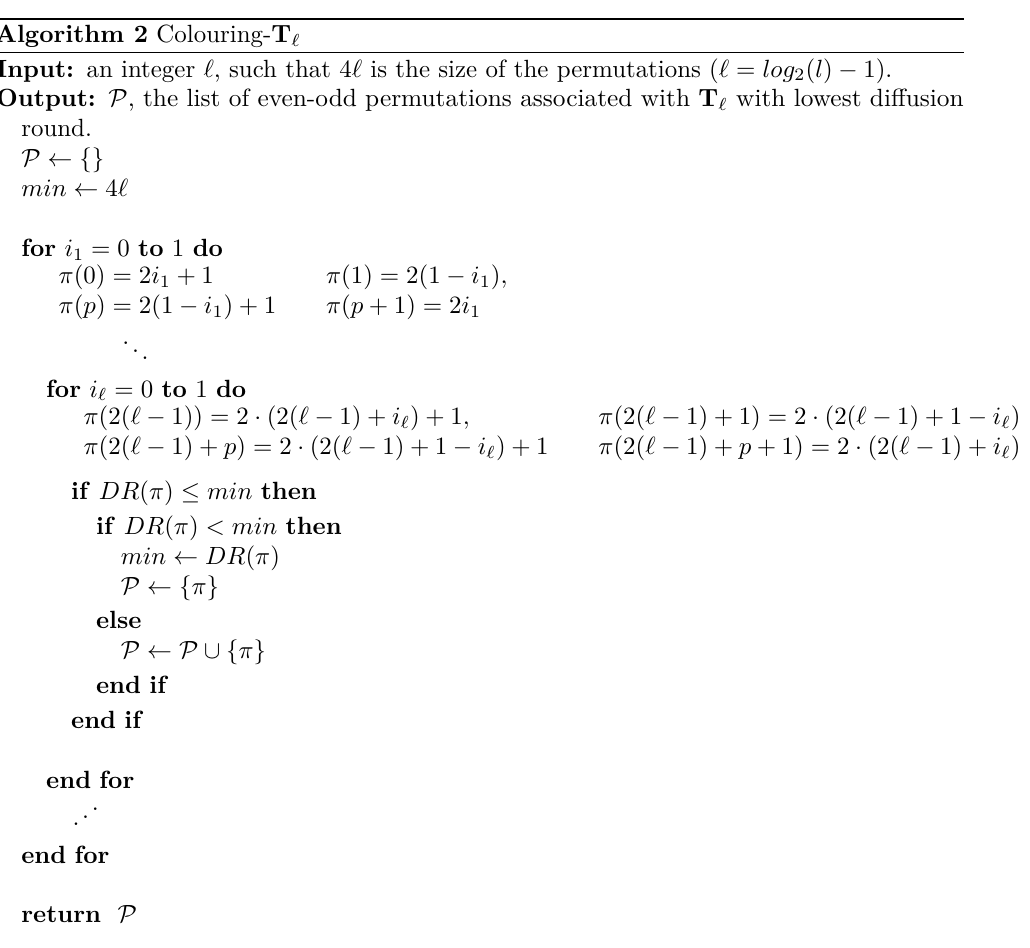
Algorithm 2 Colouring- T